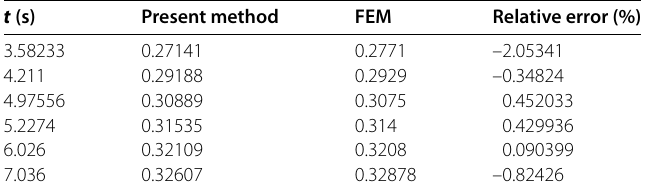
Table 4 The results of θ obtained from the present method and the FEM in x d = 1.5